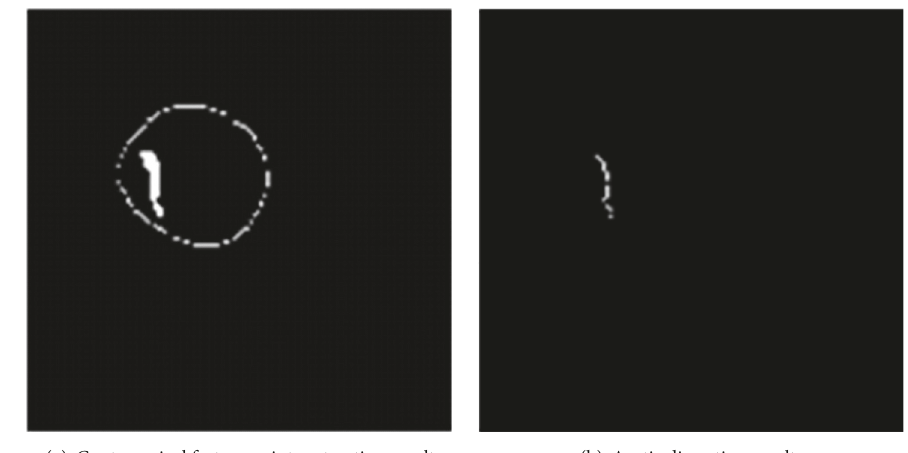
Figure 5: Final result after iteration convergence.